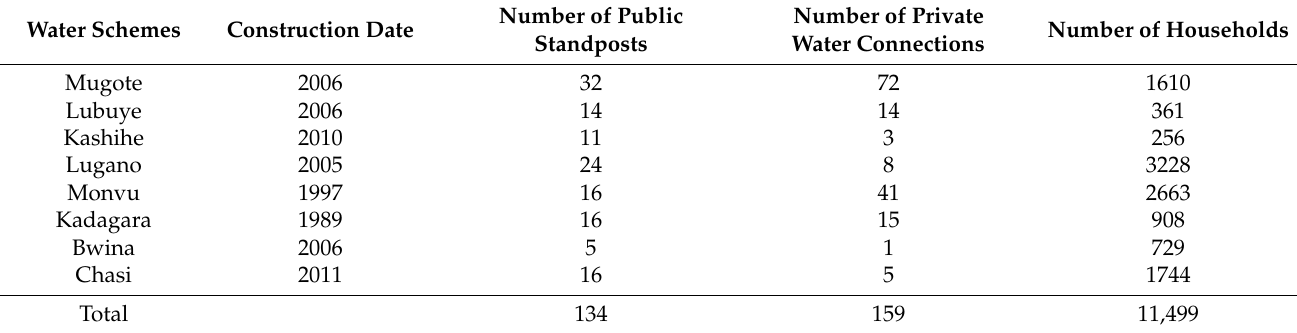
Table 1. Characteristics of the population and the